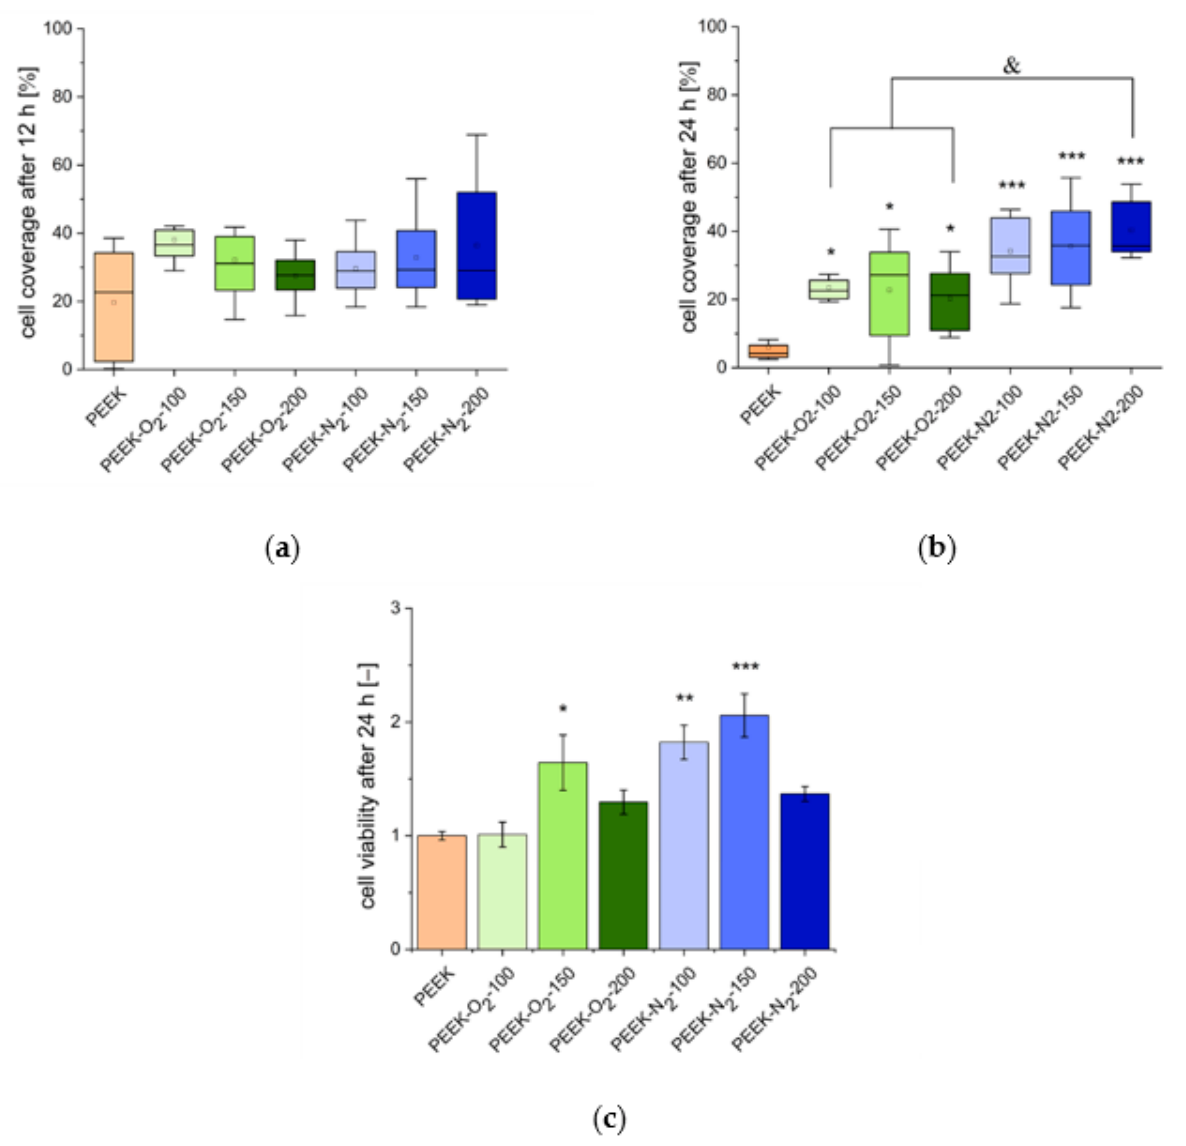
Figure 9. MG63 cell coverage after 12 ( a ) and 24 h ( b ) of culture and cell viability after 24 h of culture ( c ). MV ± SD, n = 9, * p < 0.05, ** p < 0.01, *** p < 0.005 vs. control (PEEK), & p < 0.05.